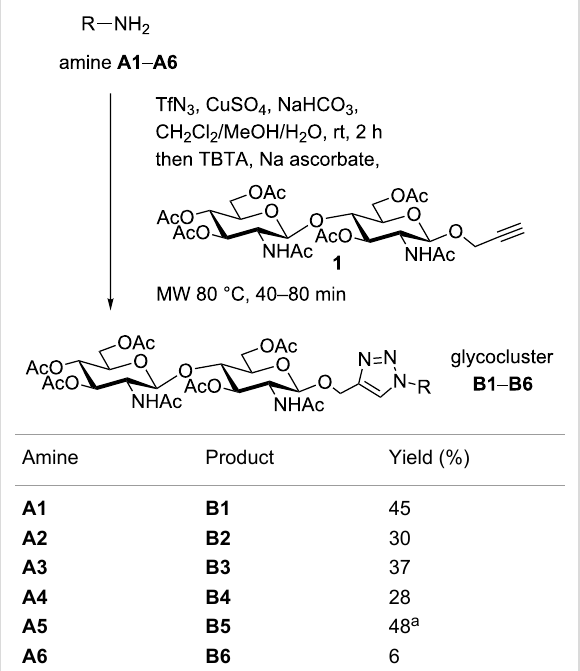
Table 1: Synthesis of glycoclusters B1 – B6 using the one-pot proce- dure for diazo transfer and azide-alkyne